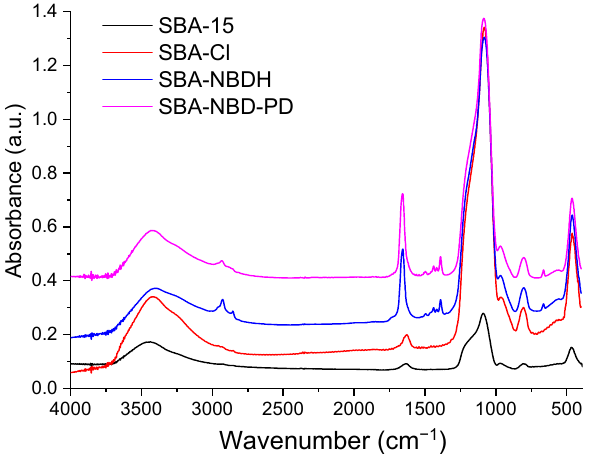
by the very intense bands of silica. The presence of these new bands evidences the suc- cessful grafting of the nitrobenzofurazan derivatives on the silica surface.